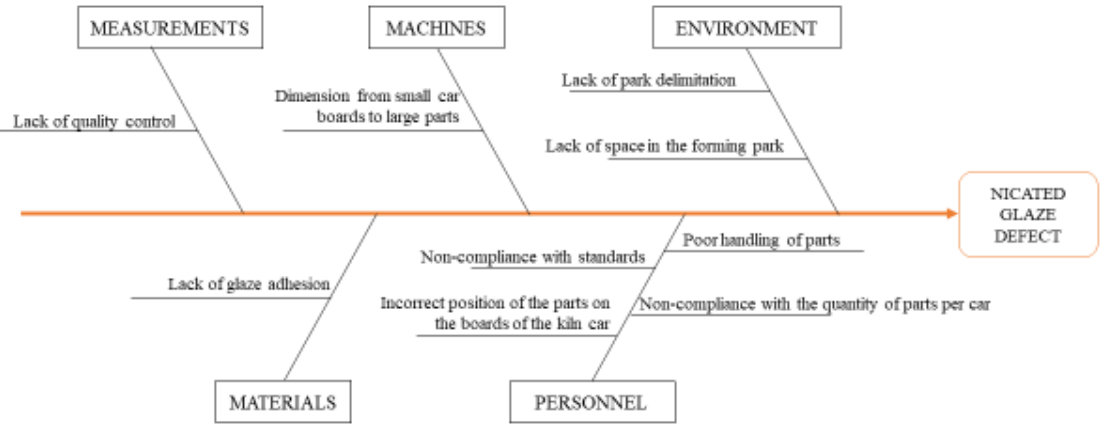
Figure 3. Ishikawa diagram of the chipped glaze defect.